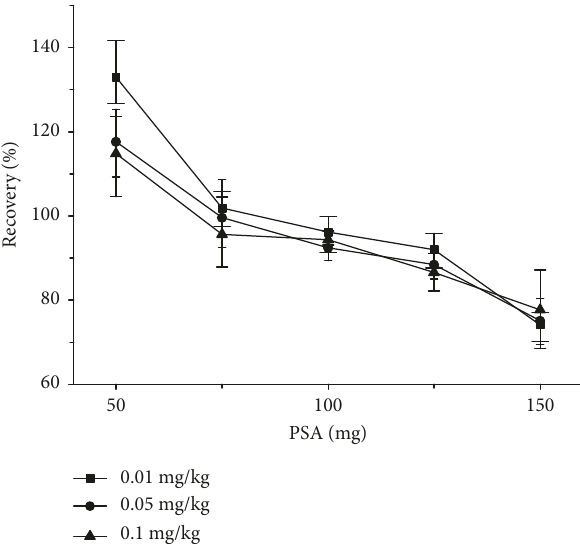
Figure 2: The optimization for amount of PSA ( n